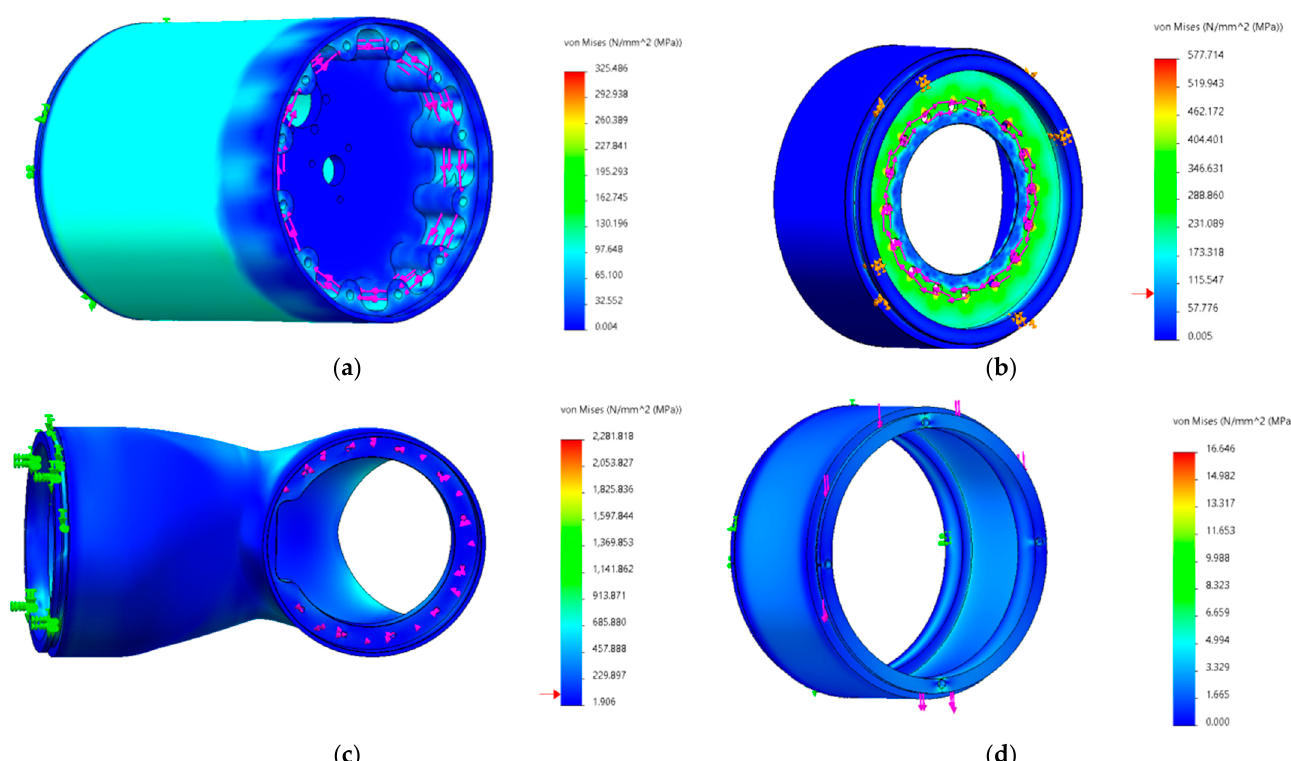
Figure 24. Robot structure force simulation. ( a ) 1-type modular motor base, ( b ) 1-type modular reducer base, ( c ) 7-type modular base, ( d ) extend base.